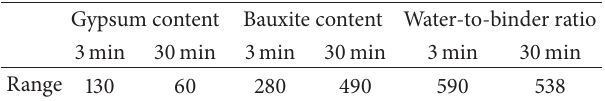
Table 5: Range analysis